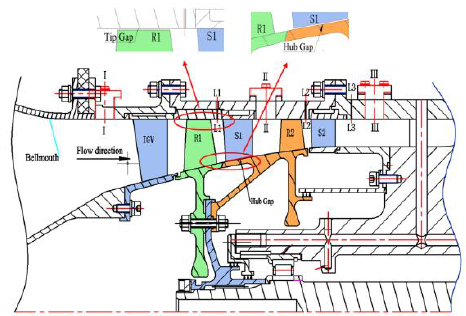
Figure 1. Schematic diagram of the 2.5-stage highly loaded compressor. Table 1. Key aerodynamic and geometric parameters of the 2.5-stage highly loaded compressor.